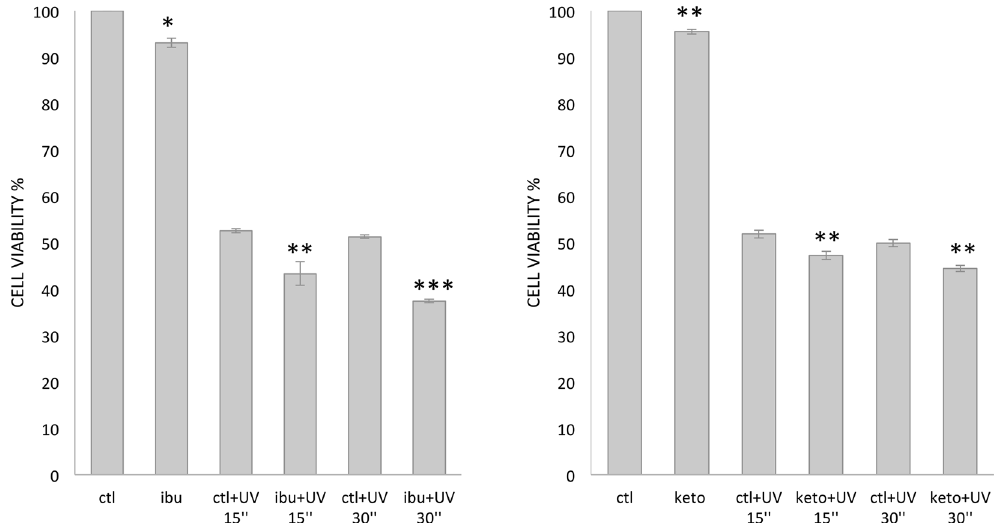
Figure 2. Ibuprofen (left) and ketoprofen (right) reduced cell viability upon UV radiation. Cell viability was assessed by MTT assays on MCF-7 cells untreated (ctl), or treated with 500 µ M of ibuprofen/ketoprofen (ibu/ keto), and/or irradiated with UV 15 s or 30 s. Cells were pretreated with 500 µ M of ibuprofen or ketoprofen for 24 h before UV irradiation and reincubated for 17 h. Significance of untreated vs ibuprofen or ketoprofen treated cells are represented with * for P < 0.05, ** for P < 0.01, *** for P <